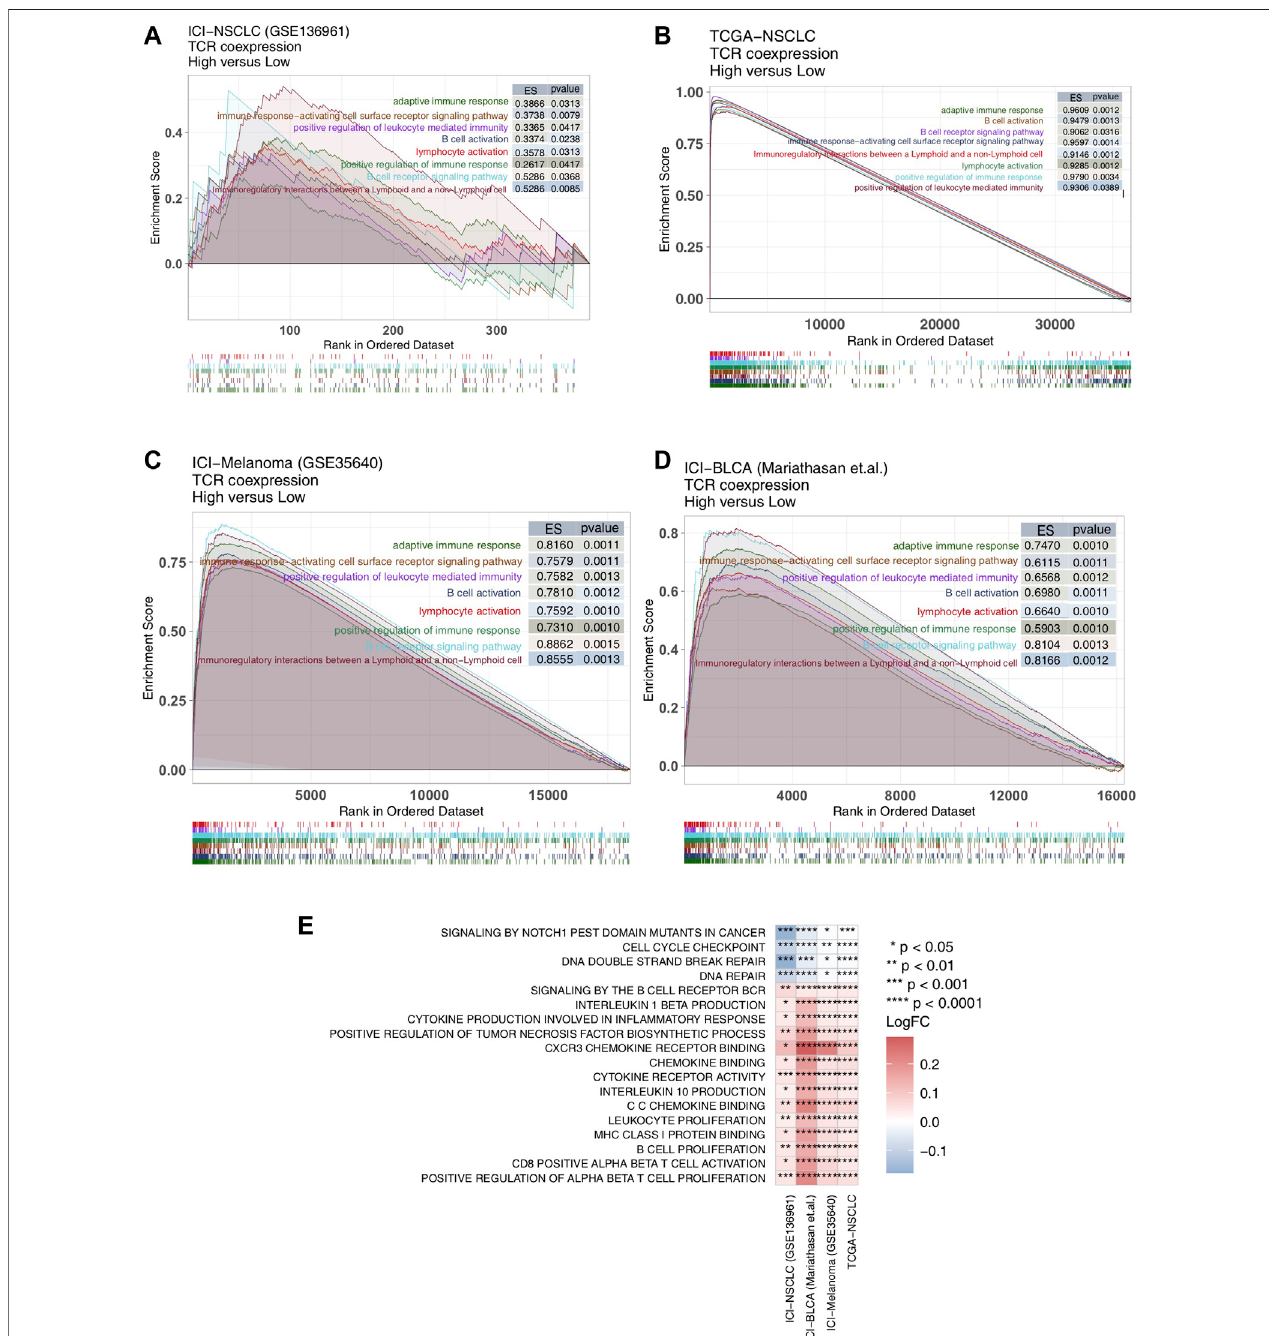
FIGURE5| HighTCRcoexpressionsignaturewasassociatedwithahighdegreeofactivated immune-related signaling pathways. ResultsoftheGSEAfortheICI- NSCLC (A) ,TCGA-NSCLC (B) ,ICI-Melanoma(GSE35640) (C) ,andICI-BLCA(Mariathasanetal.) (D) cohorts.ThelowTCRcoexpressionsignaturegroupservedasthe control group. Enrichment score (ES) > 0 indicates that the corresponding pathways were signi fi cantly enriched in the experimental groups (high TCR coexpression signaturegroup).Thecolorofthecurvescorrespondstothefontcolorsofthepathwaynames. (E) HeatmapdepictingthemeandifferencesinthessGSEAscoreof signaling pathways betweenhigh- and low-TCRcoexpressionsignaturegroups acrossdifferentcohorts. The x -axis ofthe heatmapindicatesdifferentcohorts, and the y -axisindicatessignalingpathways.EachsquarerepresentsthefoldchangeordifferenceofeachindicatedssGSEAscoreofsignalingpathwaysbetweenhigh-andlow- TCR coexpression signature groups in each cohort. Red indicates up-regulation; blue indicates down-regulation.